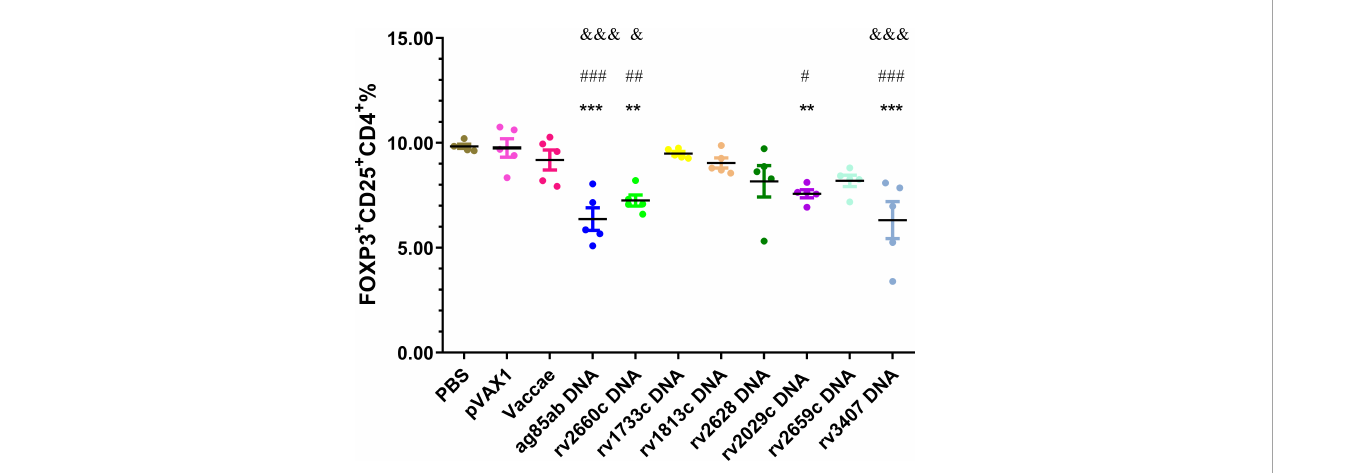
FIGURE 5 The proportion of CD4 + CD25 + Foxp3 + cells in splenocytes was evaluated by fl ow cytometry. In comparison with PBS group: ** P < 0.01, *** P < 0.0001; Comparison with pVAX1 vector group: # P < 0.05, ## P < 0.01, ### P < 0.0001; Comparison with Vaccae vaccine group: & P < 0.05, &&& P < 0.0001.